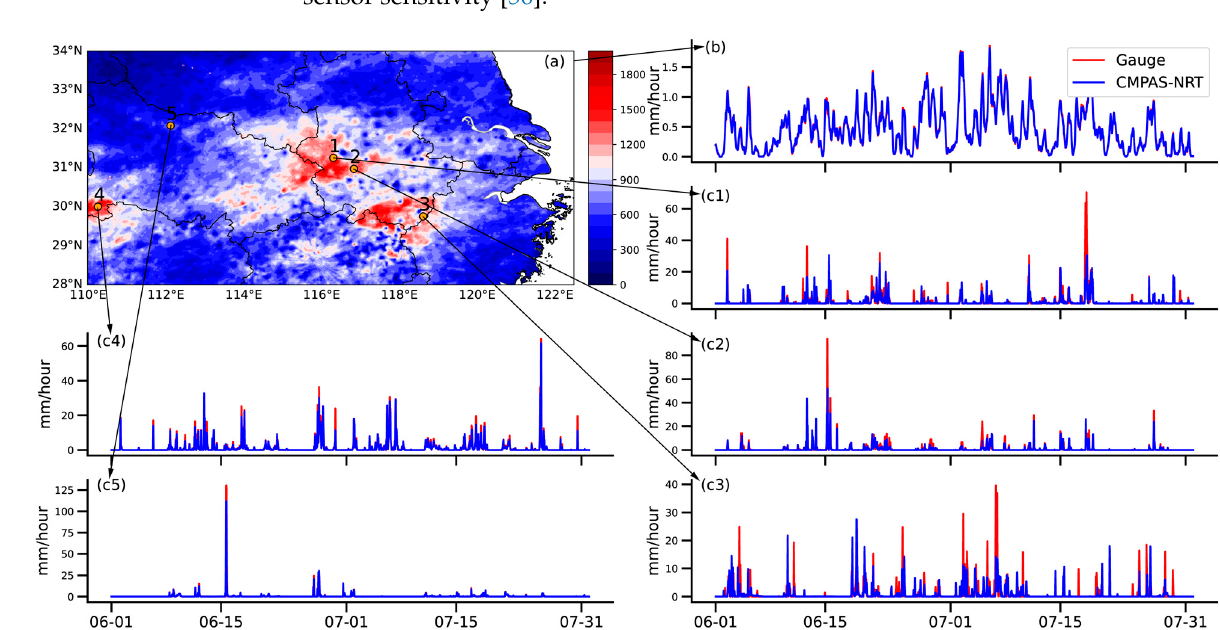
Figure 8. Spatial distribution of accumulated precipitation in the RMSE during the rainy season of 2020 ( a ), hourly time series of average precipitation in the area of rain-gauge observations (red) and CMPAS-NRT products (blue) in the RMSE ( b ), and hourly time series of precipitation for selected grid cells ( c1 – c5 ), where ( c1 – c3 ) are three grid points with RMSE greater than 2.5 mm/h, ( c4 ) is the grid point with the largest cumulative precipitation, and ( c5 ) is the grid point with the largest hourly precipitation.